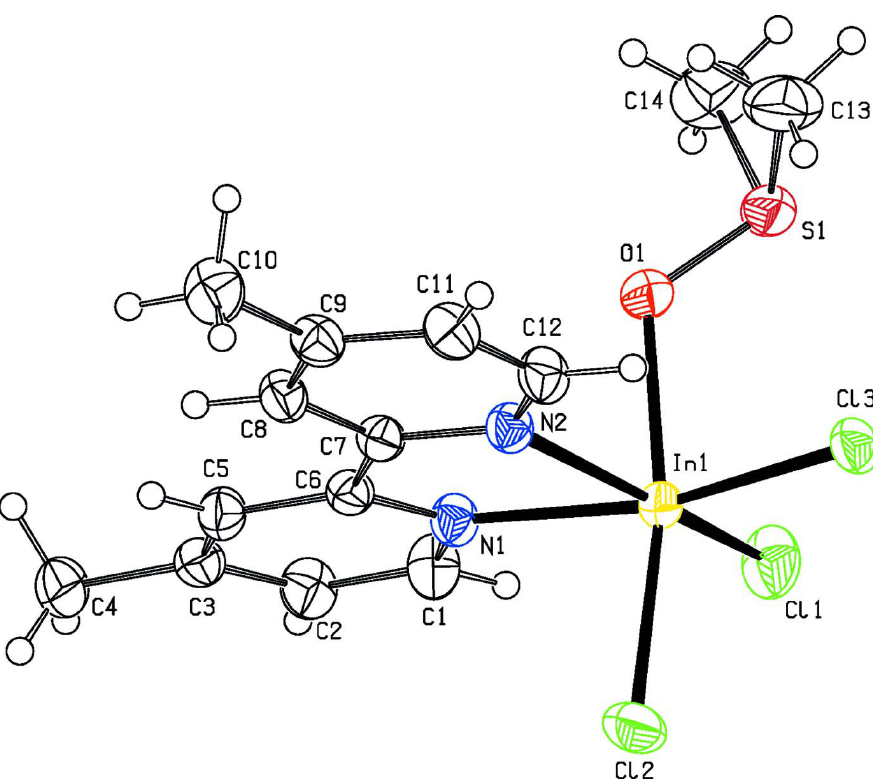
Figure 1 The molecular structure of the title molecule, with the atom-numbering scheme. Displacement ellipsoids are drawn at the 40% probability